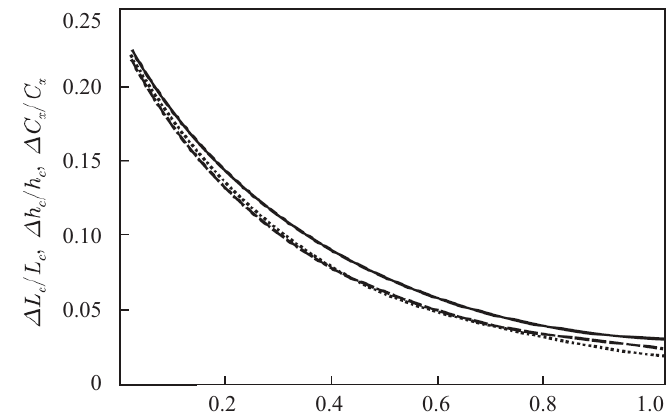
Figure 5. Relative difference of the cavity width (solid line), length (dashed line), and force coefficient (dotted line) for Weber numbers We = 2000 and We = 200, versus the cavitation number. The edge radius is r =